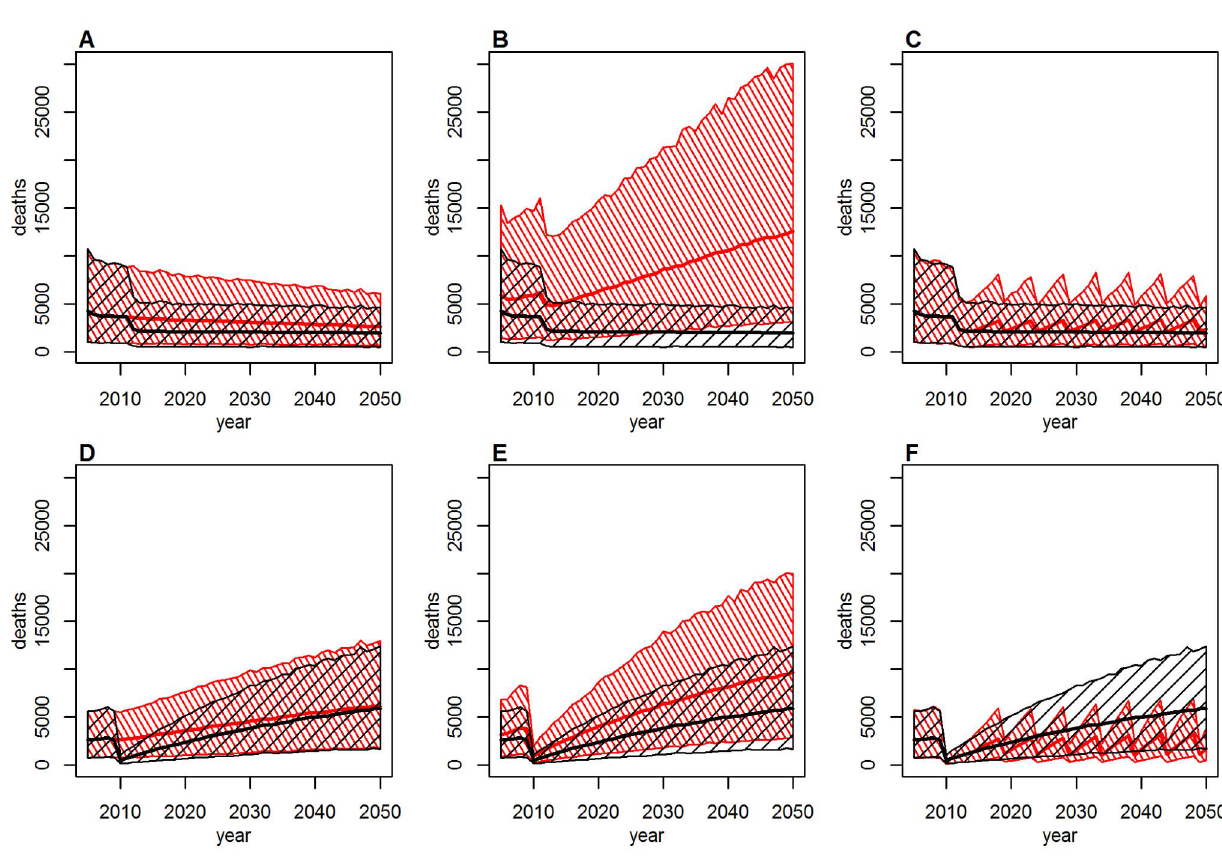
Figure 4. Deaths over time under various vaccination coverage scenarios for Ghana (top: A–C) and Liberia (bottom: D–F). Thick lines show the point estimate, hashed areas the 95% credibility intervals. Baseline scenario (black) in (A–F) includes past mass vaccination and infant immunization, plus continuing infant immunization at 2011 coverage levels. Alternative scenario (red): (A and D): as baseline, but excluding the mass vaccination campaigns; (B and E): as baseline, but assuming no infant immunization at any time; (C and F): as baseline, but including mass vaccination campaigns targeting children under 5 every 5 years at a coverage of 90% instead of future infant immunization. doi:10.1371/journal.pmed.1001638.g004 PLOS Medicine |